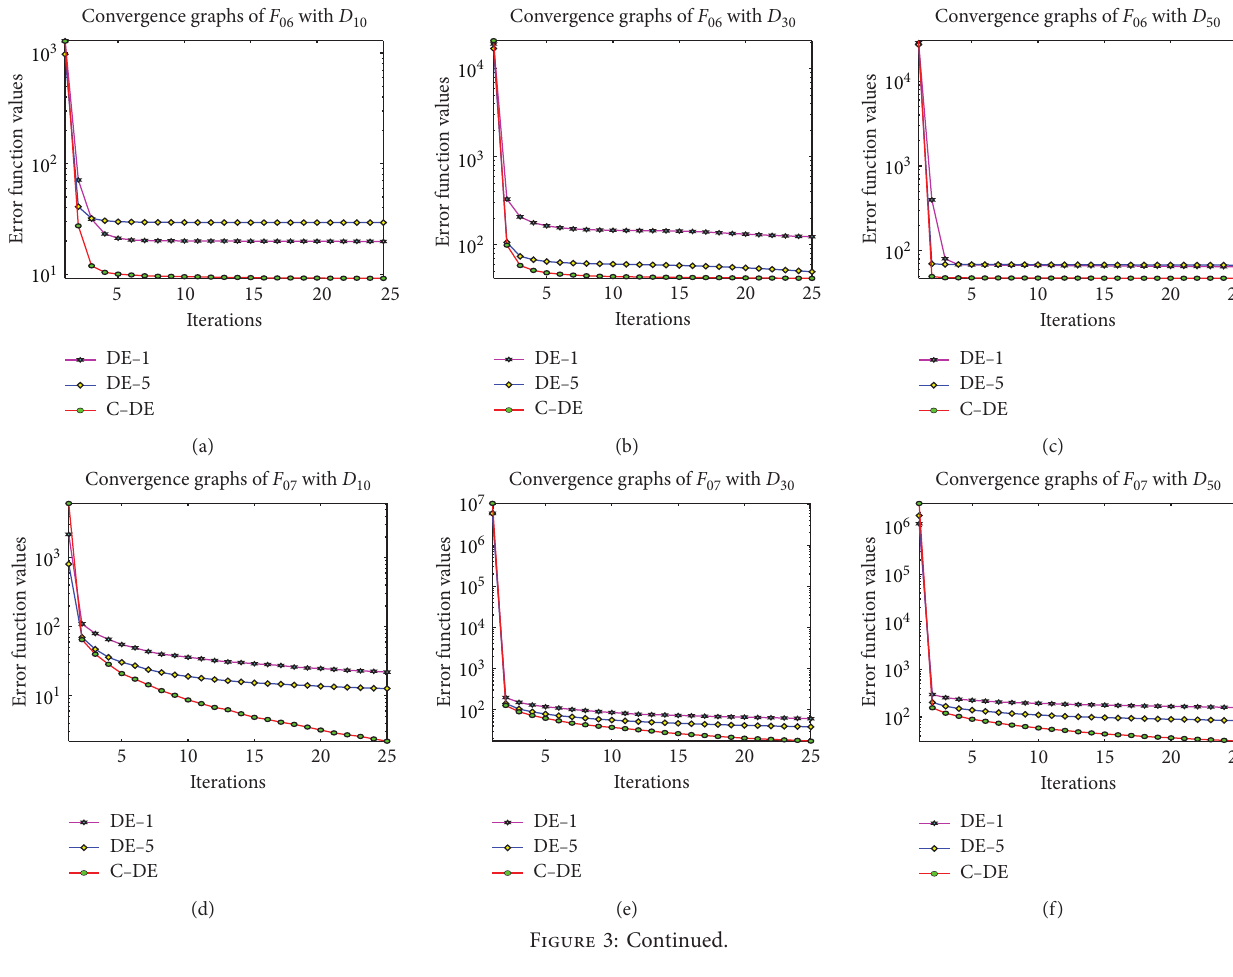
to F solved with DE-1, DE-5, and C-DE in n � 10, 30, and 50 dimensions. 1 5